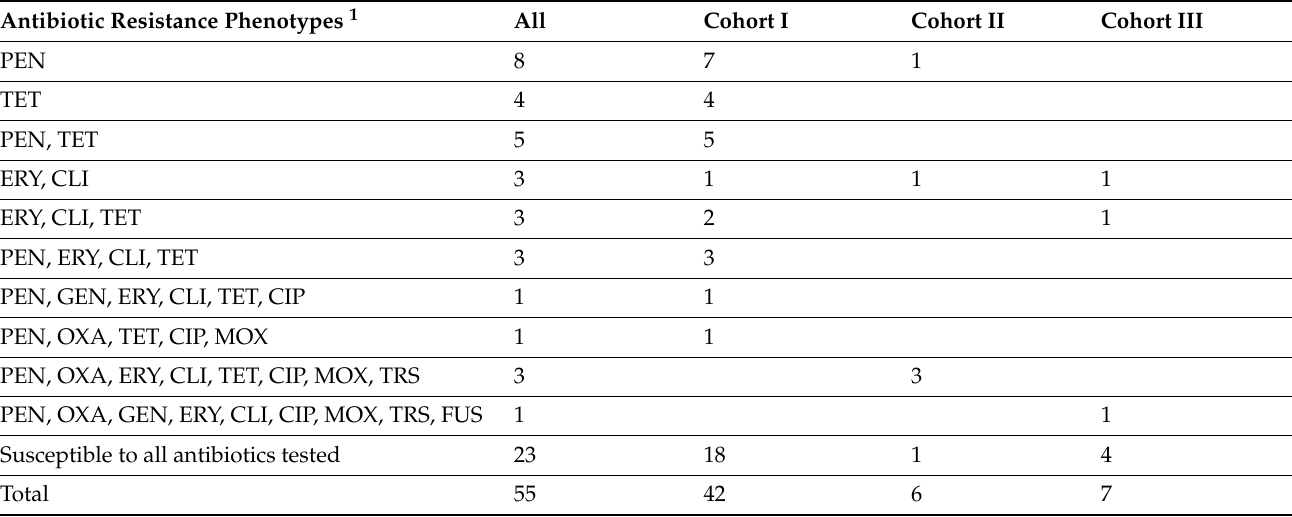
Table 5. Antibiotic resistance phenotypes of S. pseudintermedius from dogs in the cohorts. Antibiotic Resistance Phenotypes